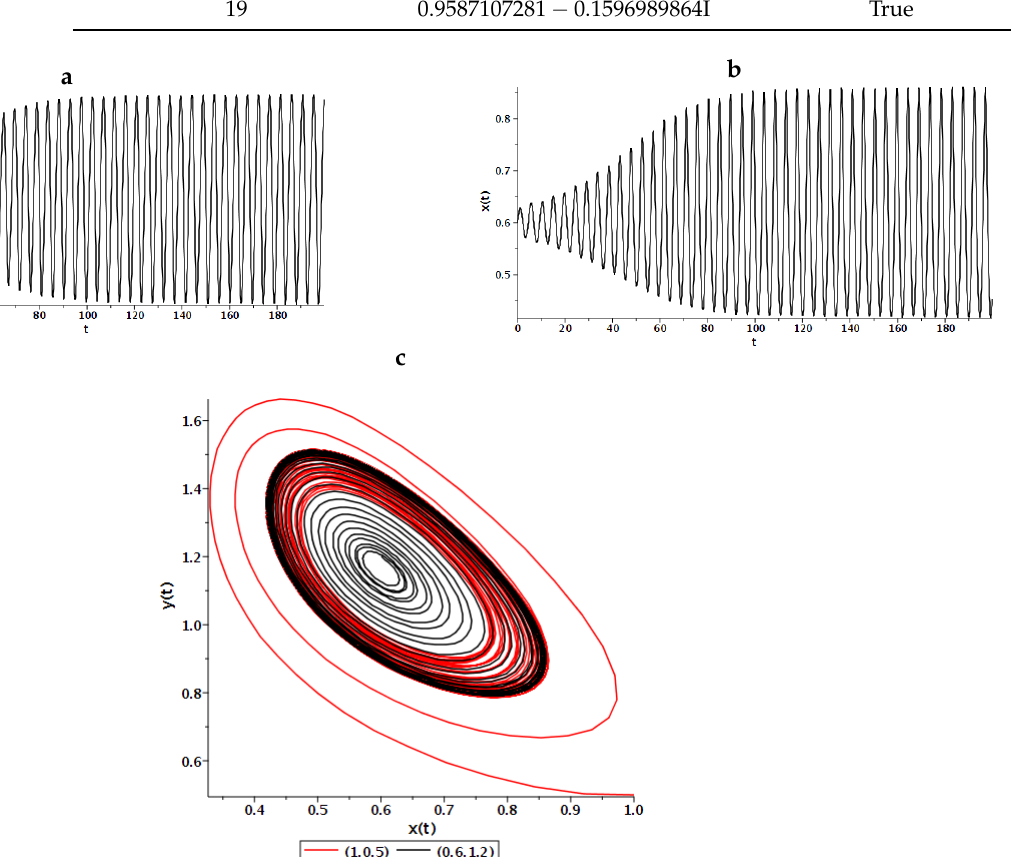
Figure 4. Oscillograms of the concentration of gs-cracks ( a ) and the tr-cracks ( b ); ( c ) phase trajectories constructed under different initial conditions for Example